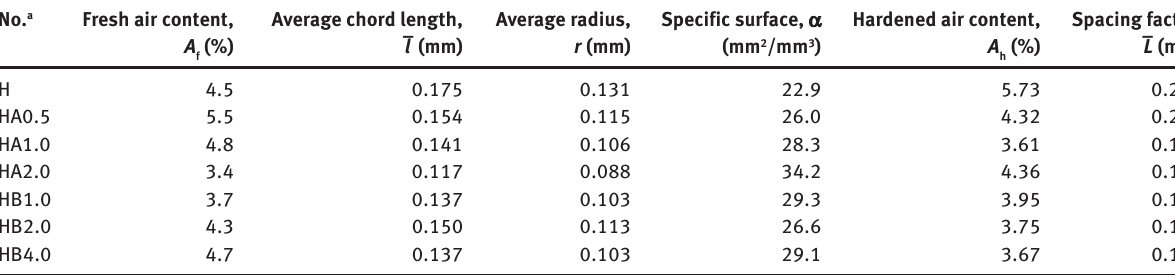
Table 3: Parameters of the air-void system in hardened concrete. No. a Fresh air